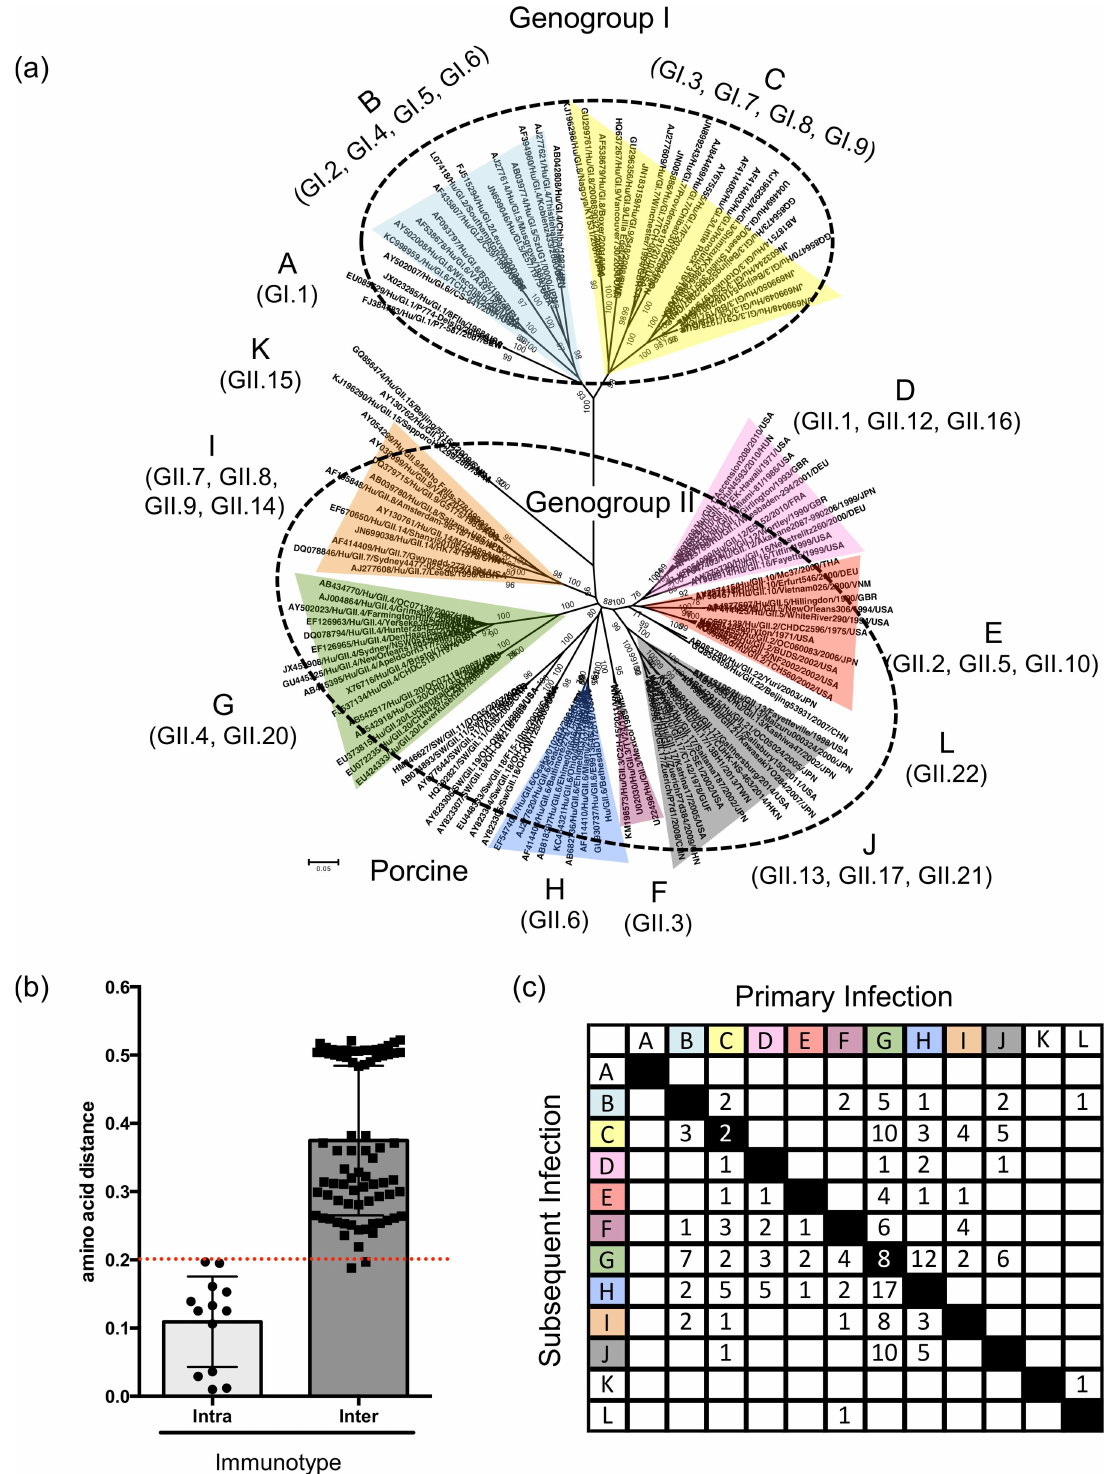
Fig 5. Clustering of human norovirus genotypes into “immunotypes”. (a) Phylogenetic treeshowingthe presence of 7 clusterscontaining two or moregenotypes and5 comprisedof a singlegenotype, whichdefinethe 12largerorderclusters designated as immunotypes (A-L) for this study. The phylogenetic tree wasconstructedusingthreerepresentative strainsfrom eachvariantdescribed for eachgenotype exceptfor GII.4, whereonlyonestrainfrom eachof the variantswas used.The